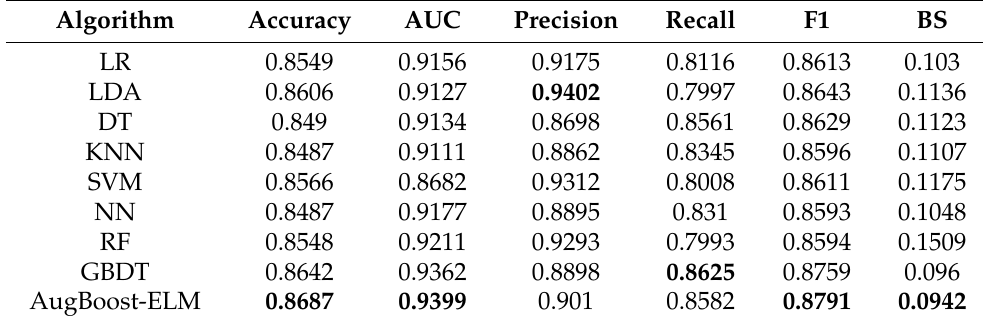
Table 6. Performance comparison of credit scoring models for the Japanese dataset.